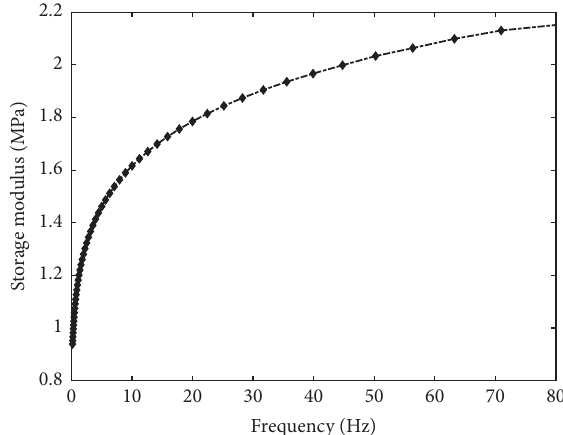
Figure 6: Energy storage modulus-frequency test curve of poly- urethane